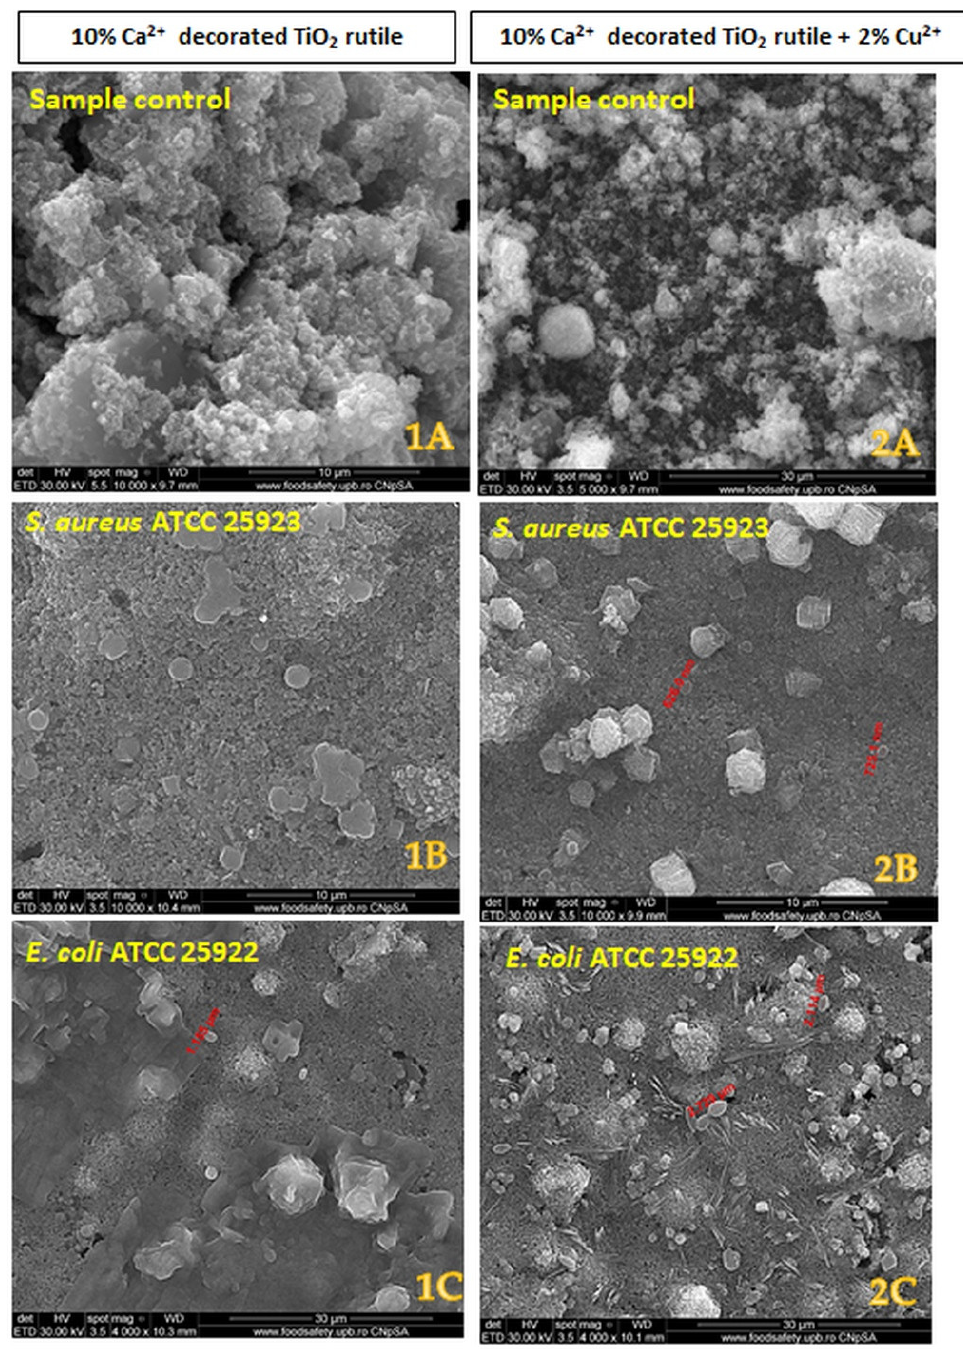
Figure 8. Scanning electron micrograph of the two pigments before and after 30 min of contact with the Gram-positive and Gram-negative bacterial cells. The left column represents sample 1; the right column represents sample 2. The bacterial strains are listed on the images. The diameters of the bacterial cells are marked on each image: ( 1A ) and ( 2A )—controls (samples 1 and 2 that aren’t put in contact with bacterial cells); ( 1B )—no bacterial cells observed; ( 2B )—626 nm; ( 1C )—1.155 µm; ( 2C )—2.720 and 2.114 µm.